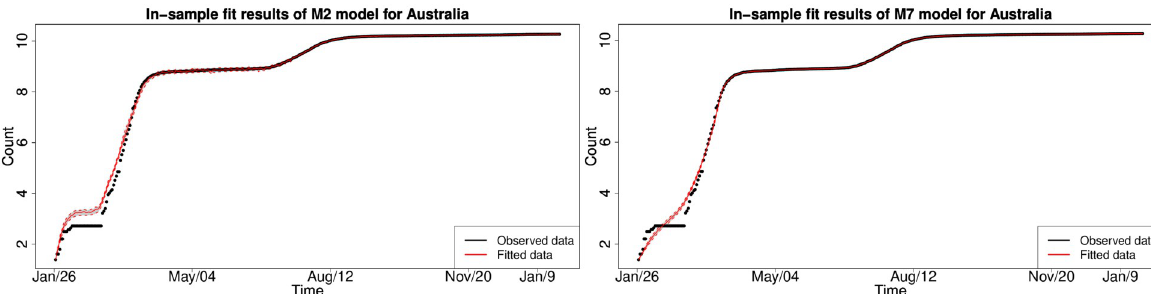
Fig 14. In-sample fit results for Australia for the period January 2020—January 2021. In-sample fitted plot (y-axis in log scale) for Australia by Model 2 (baseline, left) and Model 7 (best, right) (January 2020—January 2021).